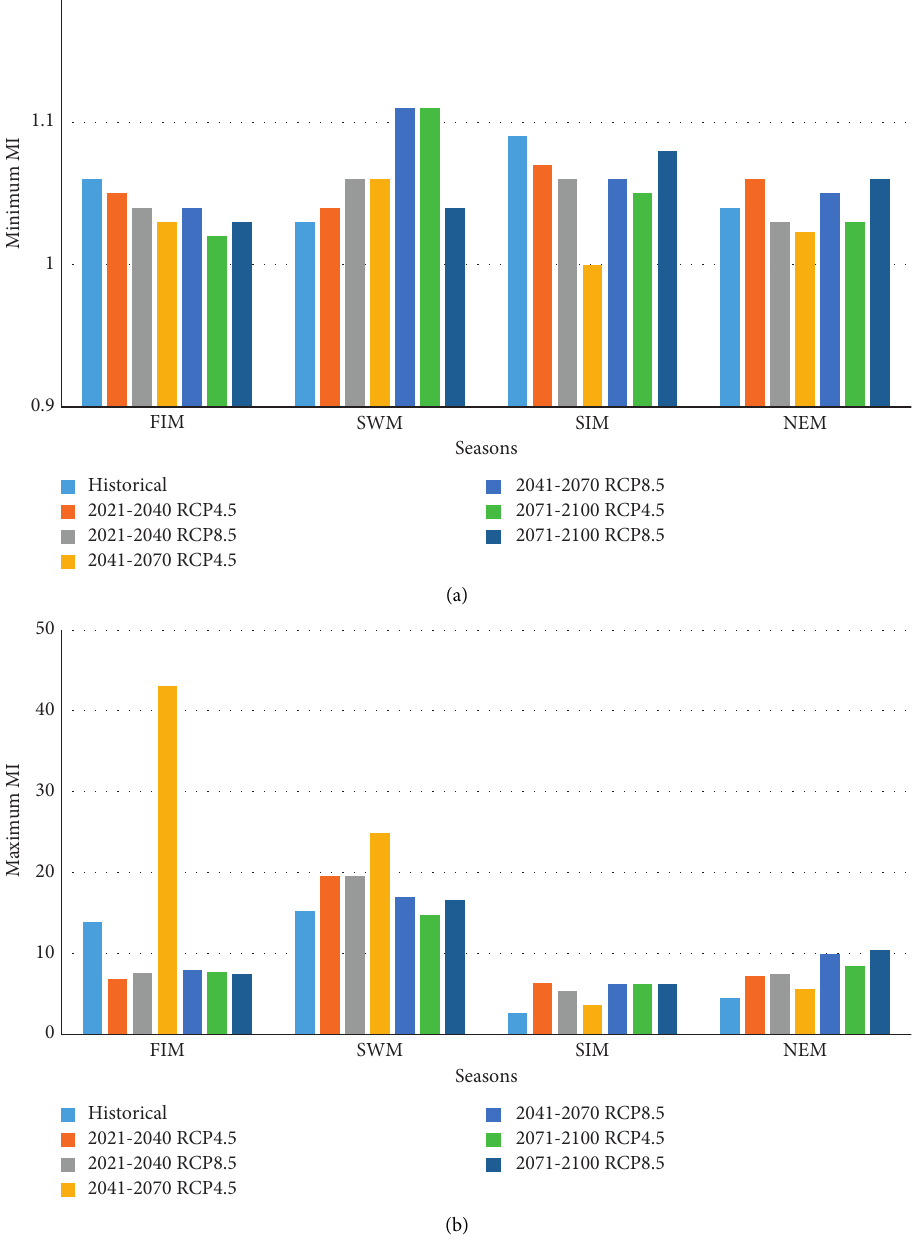
Figure 9: Comparisons of MI. (a) For minimum MI. (b) For maximum